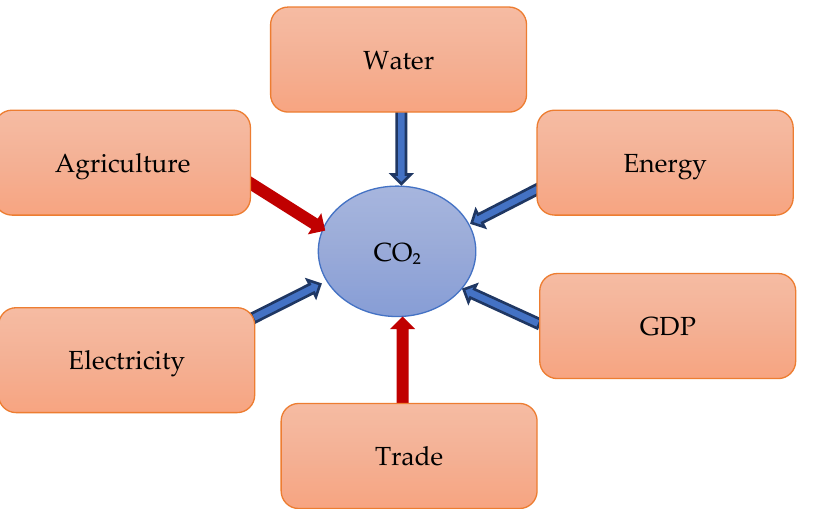
Figure 1. Graphical representation of the findings of Panel Data Models. Note: Blue sign is for positive and statistically significant at 1% level; Red sign is for negative and statistically significant at 1% level.